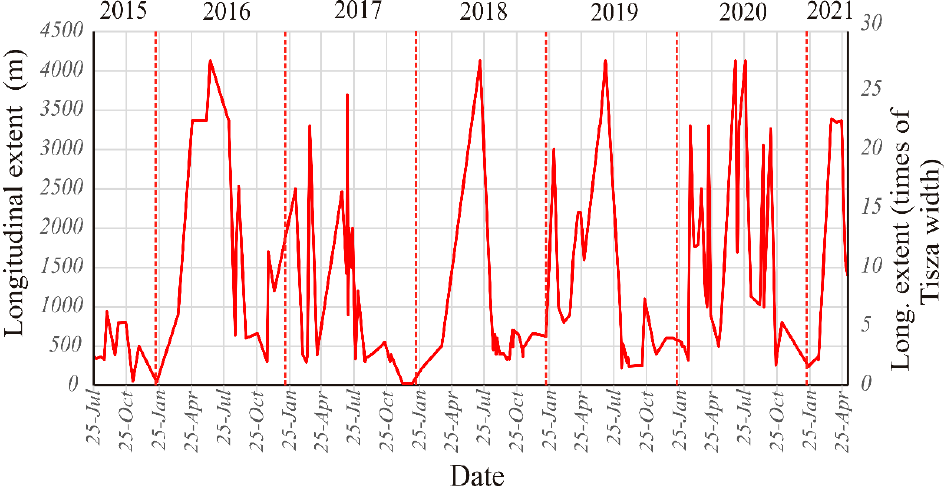
Figure 7. The longitudinal extent of Maros water (MW) into the Tisza River in the studied period.